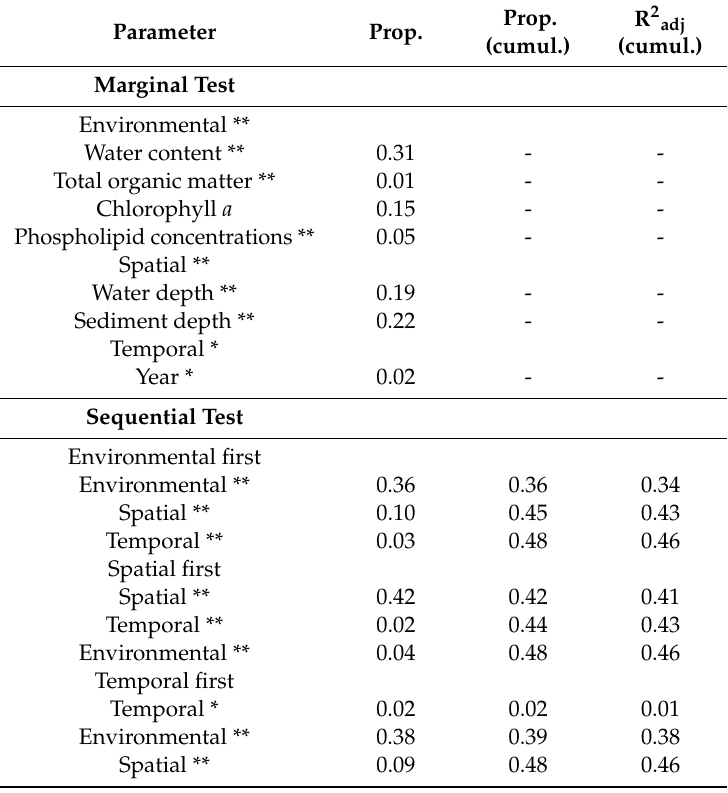
Figure 6. Variation partitioning of meiofauna taxa similarity matrix (Bray-Curtis similarity) based on square-root transformed abundance data. Table 6. DistLM (distance-based linear model) results showing the relationship between environmental (food availability and sediment porosity), spatial (water depth and sediment depth), and temporal (years) parameters on variation in meiofauna community structure (Bray-Curtis similarity of square-root transformed abundance of meiofauna taxa). Marginal test: explains the proportion of each parameter alone, ignoring all other parameters; sequential test: indicates the increase in the proportion of variation explained with each parameter added in a combined model (all specified selection procedure with adjusted R 2 selection criterion). Prop.: proportion of total variation explained; prop. (cumul.): running